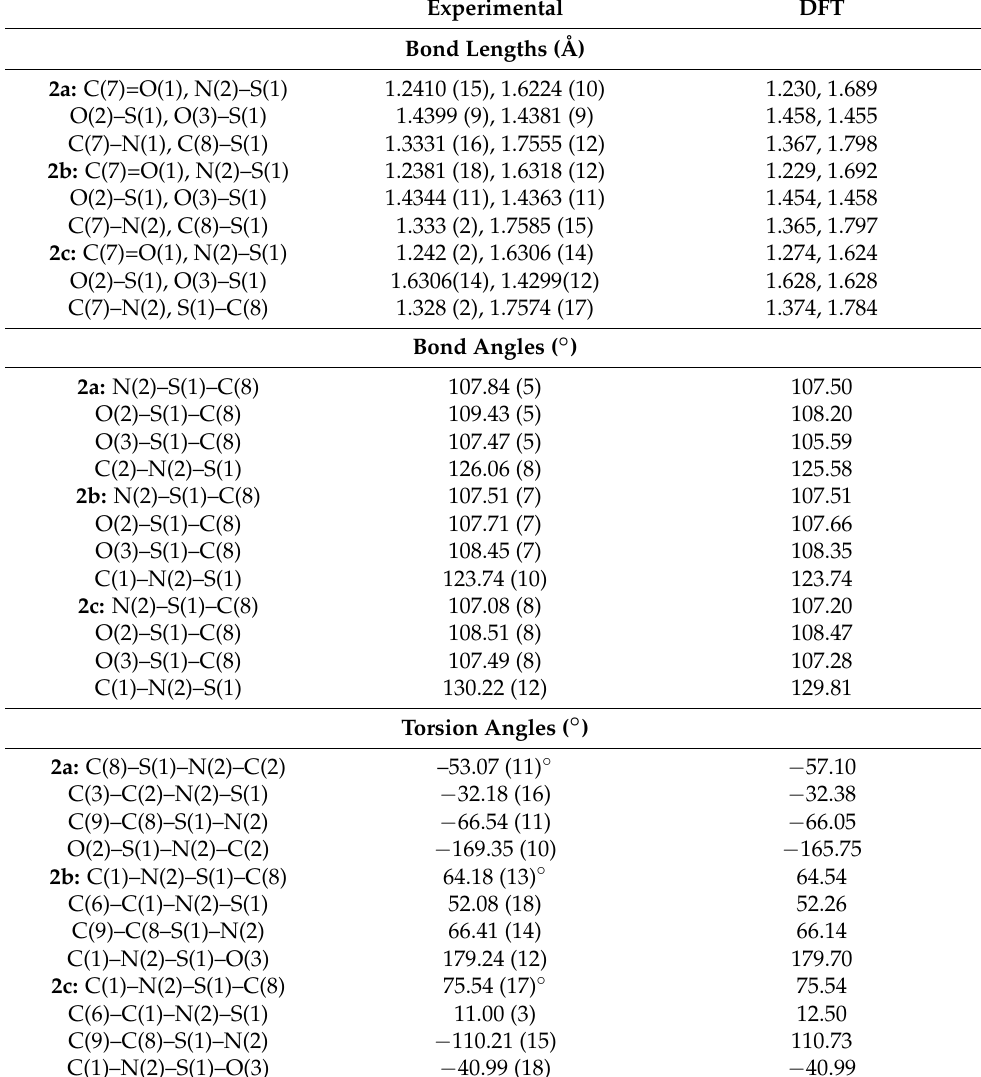
Table 3. Selected XRD and density functional theory (DFT) bond lengths (Å), bond angles ( ◦ ) and dihedral angles ( ◦ ) for 2a